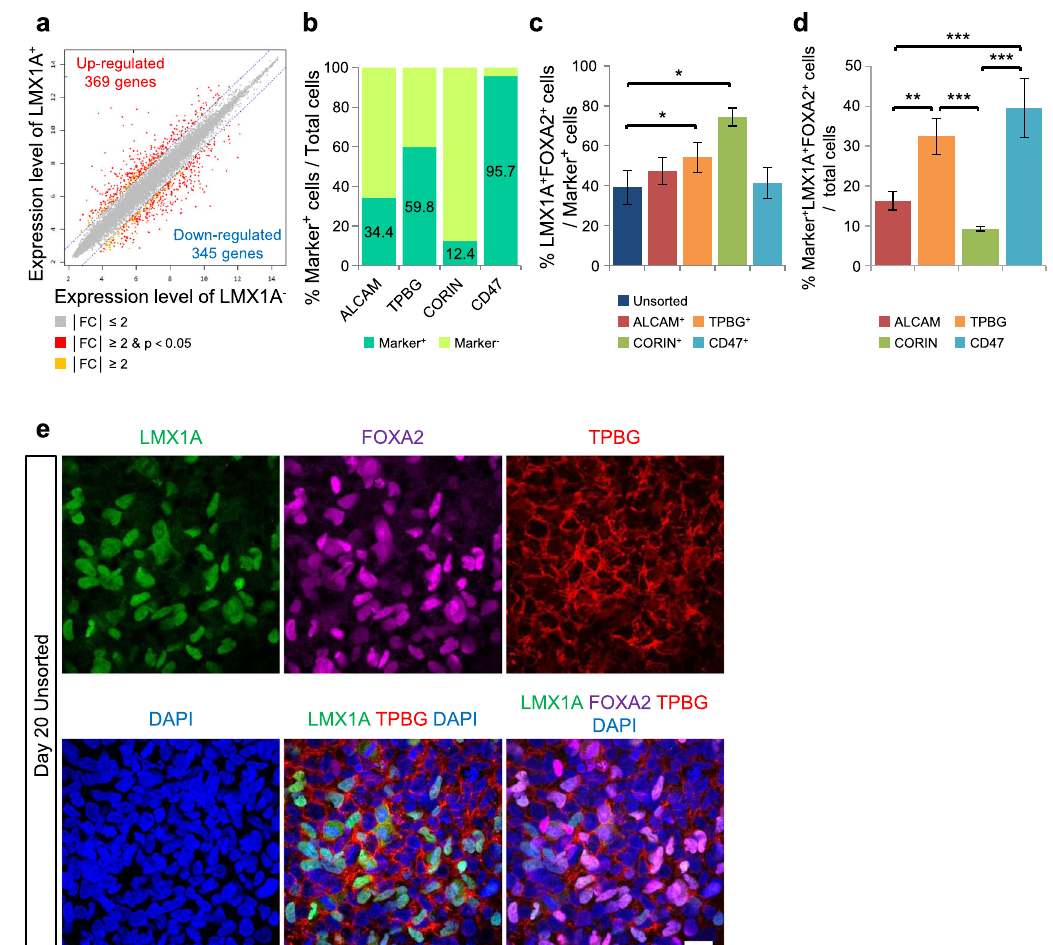
Fig. 2 Identi fi cation of TPBG as a novel marker for sorting vmDA precursors from hESCs. a Comparison of gene expression pro fi les between eGFP + (LMX1A + ) and eGFP − (LMX1A − ) cells among vmDA precursors on D20. b The ratio of separated cells via MACS targeted for each marker (ALCAM, TPBG, CORIN, and CD47) on D20 with three biological replicates. c Flow cytometry analysis of LMX1A + and FOXA2 + cells in unsorted, ALCAM + , TPBG + , and CD47 + populations on D20 with fi ve biological replicates. * p < 0.05, one-way ANOVA with Bonferroni ’ s multiple-comparison tests. d Quanti fi cation of LMX1A + FOXA2 + Marker + triple-positive cells from the total population of differentiated cells on D20 with three independent experiments. ** p < 0.01, *** p < 0.001, one-way ANOVA with Bonferroni ’ s multiple-comparison tests. e Representative fl uorescent images for the expression of LMX1A (green), FOXA2 (magenta), and TPBG (red) in vmDA precursors on D20. DAPI (blue) was used as a counterstain. Scale bar, 25 μ